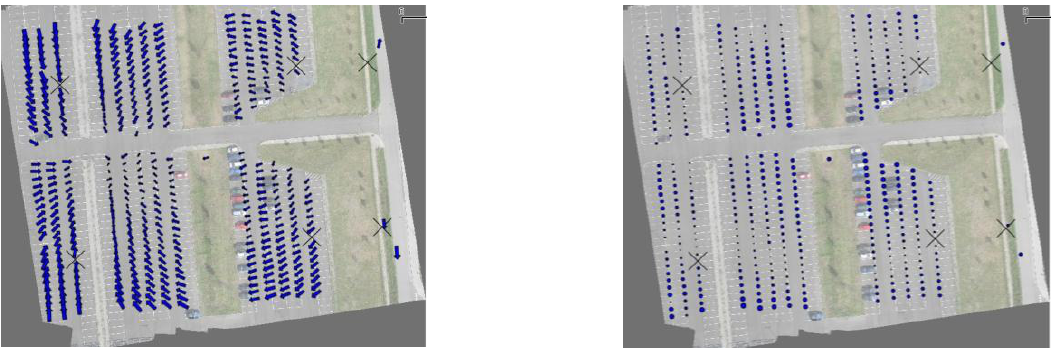
Figure 5. Positional (left) and height deviations (right) of the point cloud computed with PhotoScan